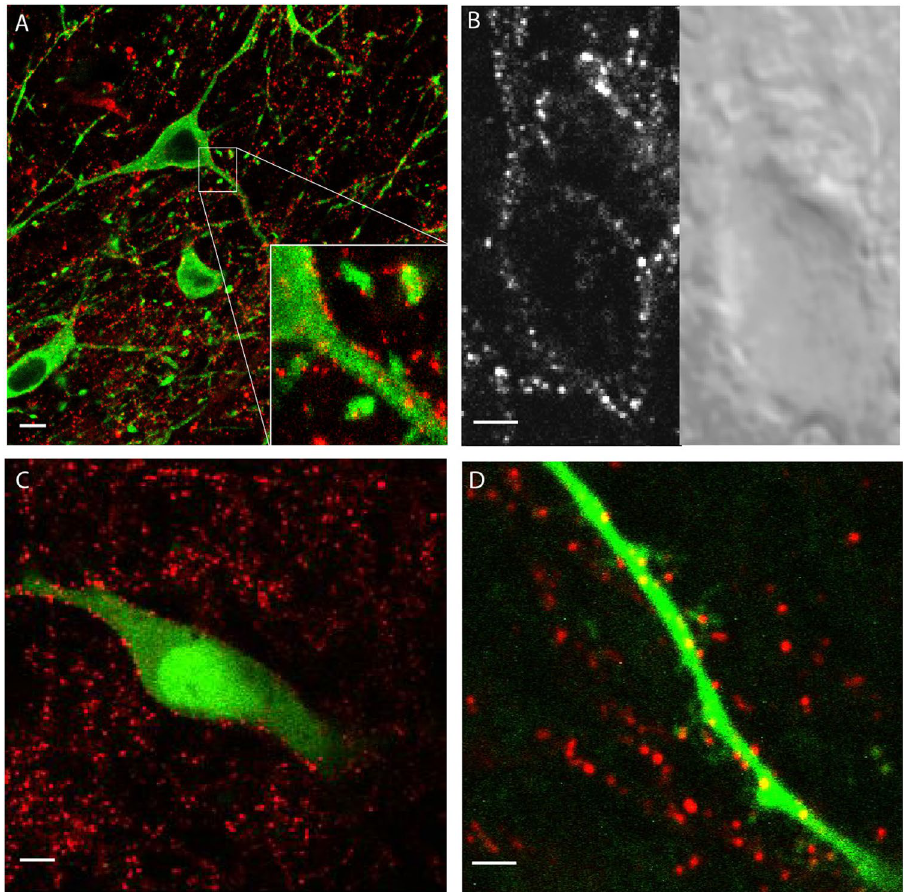
Figure 1. Visualizing the GFP-D2 receptor. ( A ) Confocal image of a slice from a GFP-D2 animal. Slice incubated in anti-GFP-AF594 (red) to amplify the signal on the D2 receptor prior to fixation. Tyrosine hydroxylase (TH) stained in green. ( B ) Simultaneously acquired 2-photon (left) and DIC (right) images of a live neuron from a GFP-D2 acute section. Slice was incubated in anti-GFP-AF594 prior to imaging. ( C ) 2-photon imaging of a live neuron filled with AF488. Slice was incubated in anti-GFP-AF594 prior to imaging. ( D ) 2-photon image zoomed in on a distal dendrite from a neuron filled with AF488. Receptors amplified with anti- GFP-AF594 (red) seen on dendritic shaft and spine-like structures. A-C scale bars 5 µ m, D scale bar 1 µ